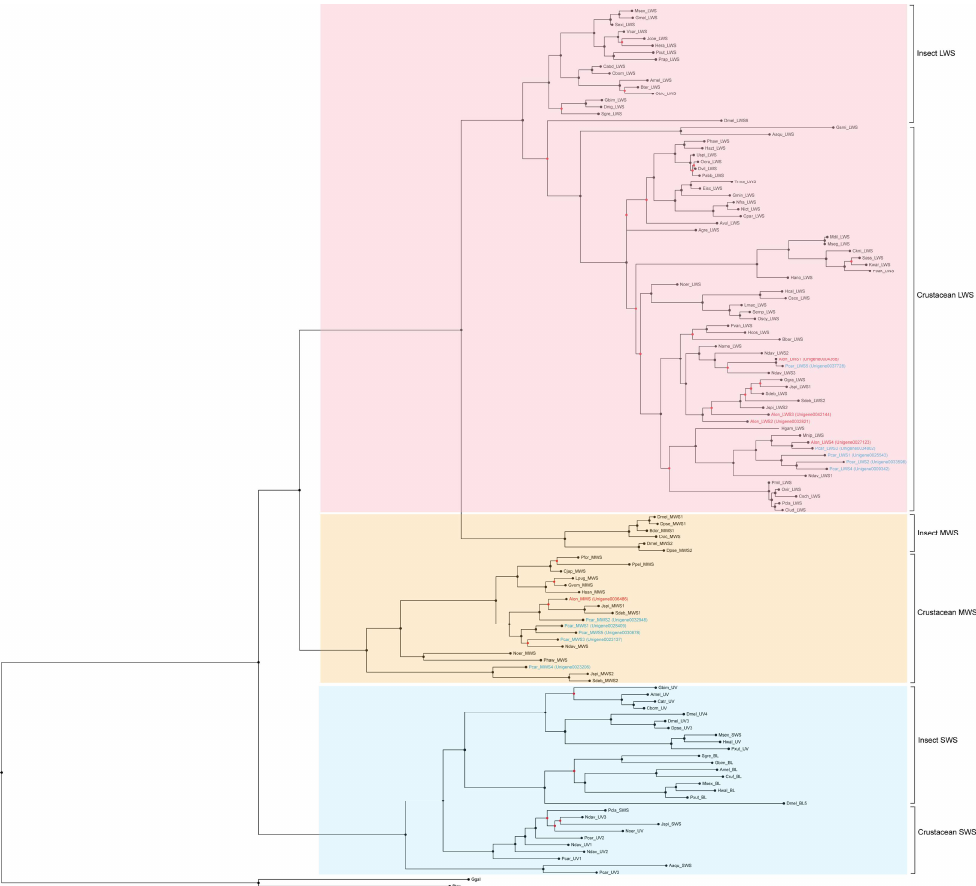
Figure 5. Maximum-likelihood phylogeny of opsin visual proteins in representative arthropod species. The tree is constructed based on the amino acid sequences. Bos taurus rhodopsin and Gallus gallus pinopsin sequences serve as out-group. Most bootstrap support is significant, and the low support is indicated by red circles (SH-aLRT < 80, or UFBoot < 95, and aBayes < 0.95). LWS (long-wavelength-sensitive) opsins, MWS (middle-wavelength-sensitive) opsins and SWS/UVS (short-wavelength/UV-sensitive) opsins are located in areas with different color. Opsins in Alvinocaris long- irostris and Palaemon carinicauda are marked with red and yellow, respectively. The detailed information of sequences used to construct phylogenetic tree is described in Table S1.